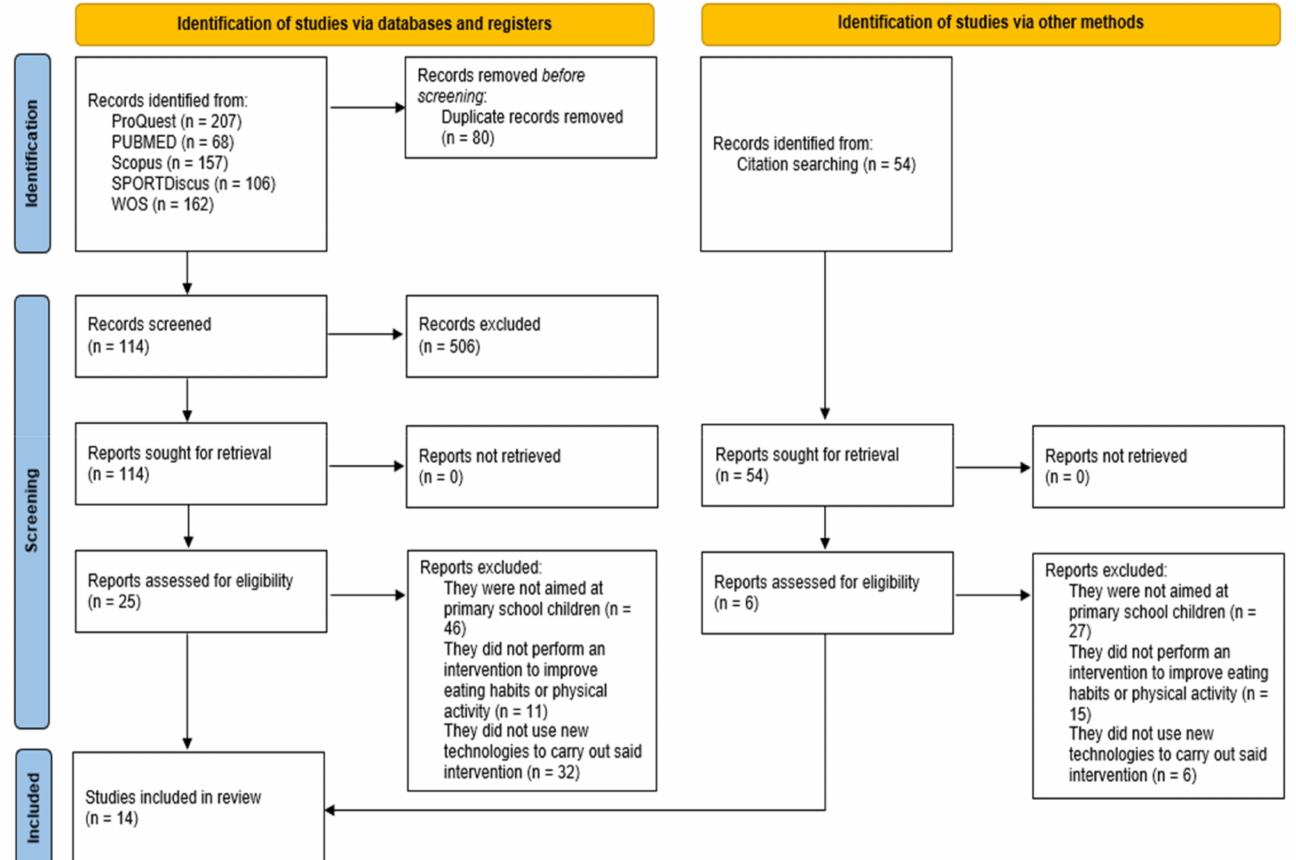
Figure 1. PRISMA 2020 flowchart of the systematic review inclusion